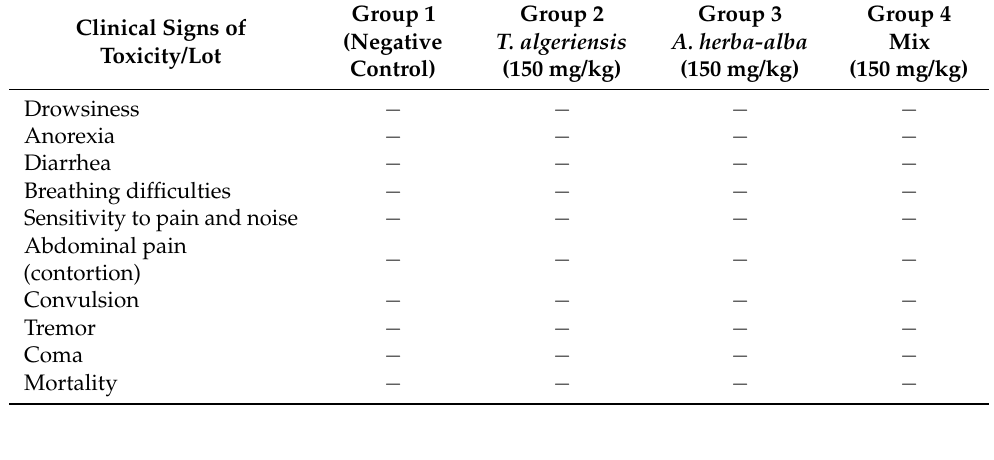
Table 3. Results of the observation of the mice every day for 14 days after oral administration of T. algeriensis and A. herba-alba and their mixture.